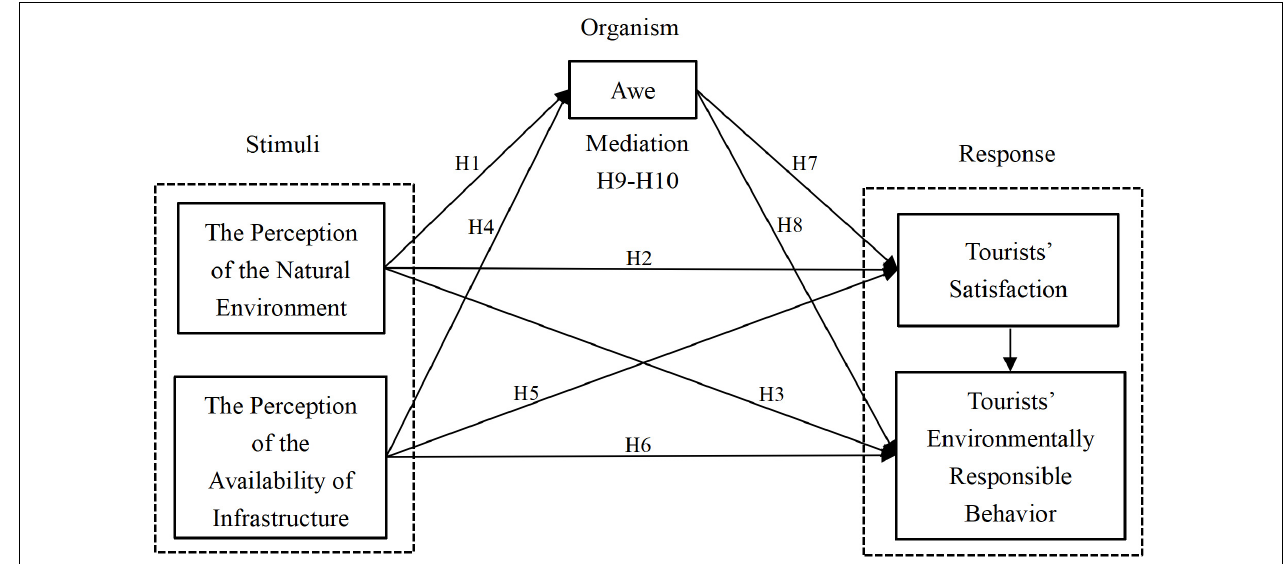
FIGURE 2 | A conceptual framework of the SOR model.